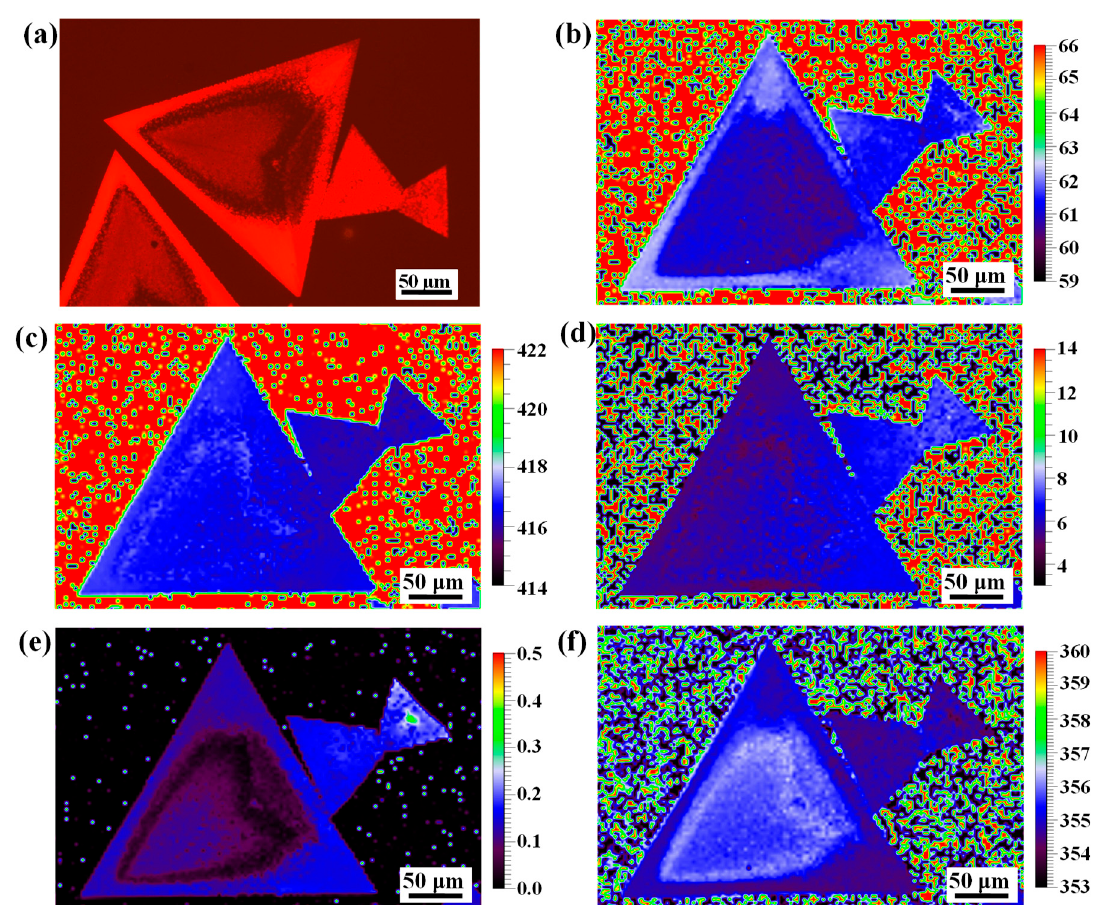
Figure 4. ( a ) FL image of the as-grown WS 2 flake on SiO 2 /Si substrate, its optical image is shown in Figure 2a. ( b – f ) Raman mappings of the specific WS 2 sample: frequency difference between A (cid:2869)(cid:2917) (cid:4666)Г(cid:4667) and E (cid:2870)(cid:2917)(cid:2869) (cid:4666)Г(cid:4667) modes ( b ), frequency of A (cid:2869)(cid:2917) (cid:4666) Г (cid:4667) mode ( c ), full width of half maximum (FWHM) of A (cid:2869)(cid:2917) (cid:4666) Г (cid:4667) mode ( d ), normalized intensity of A (cid:2869)(cid:2917) (cid:4666) Г (cid:4667) mode ( e ), and frequency of E (cid:2870)(cid:2917)(cid:2869) (cid:4666)Г(cid:4667) mode ( f ).